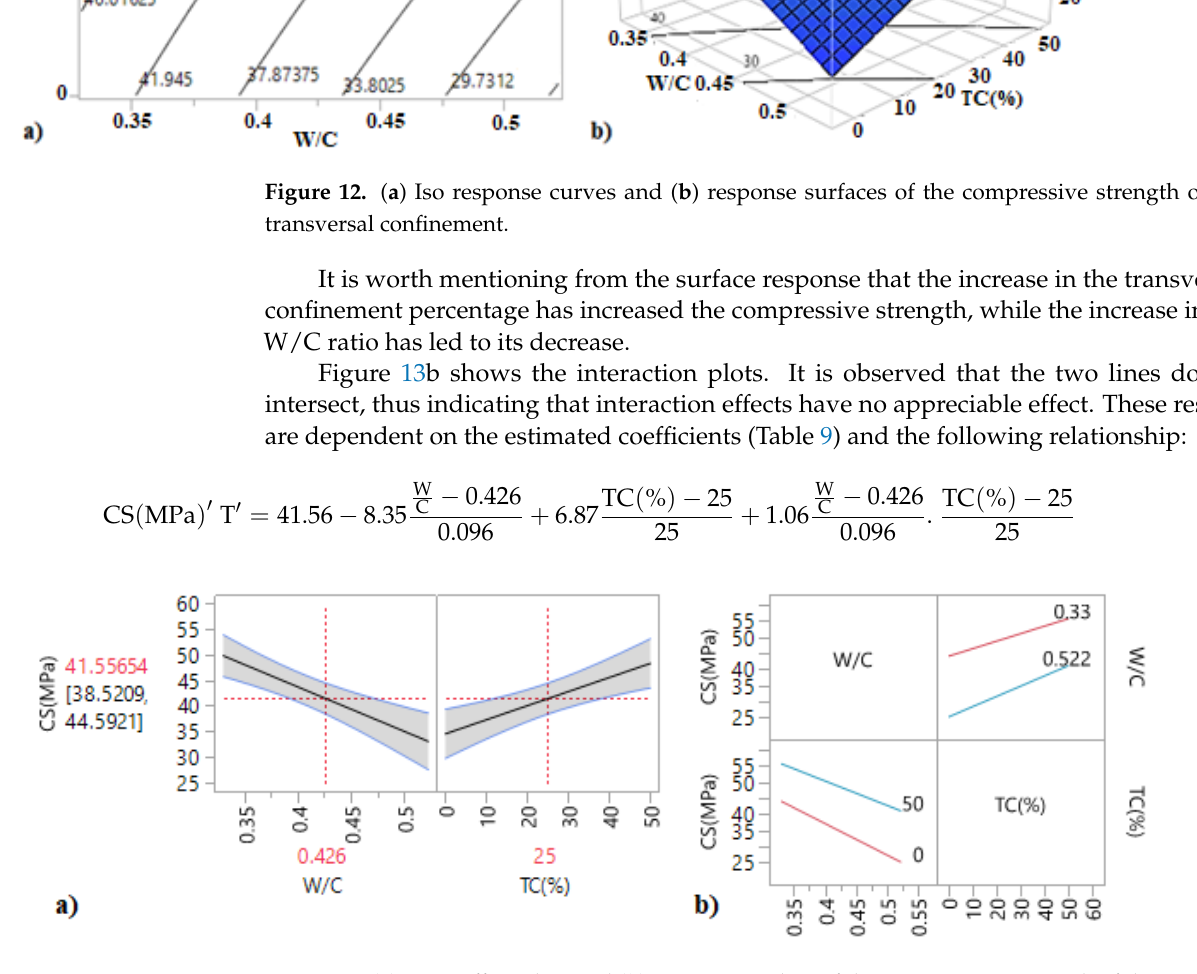
Figure 13. ( a ) Main effect plots and ( b ) interaction plots of the compressive strength of the transver- sal